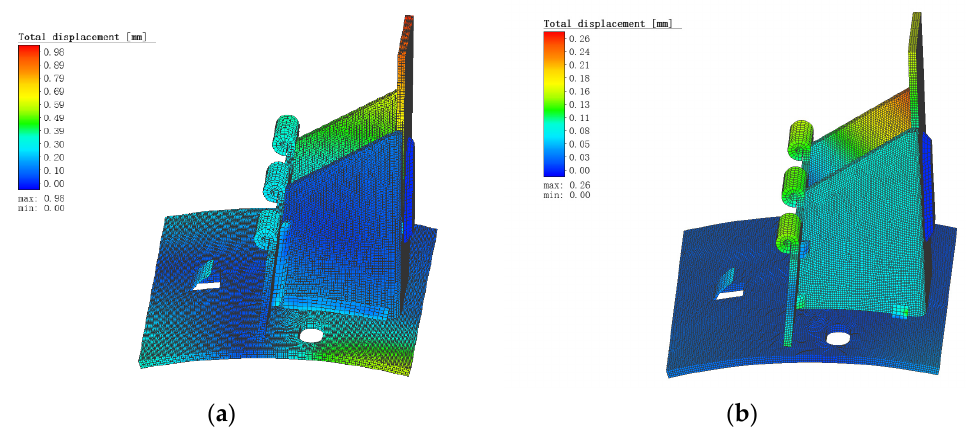
Figure 7. Total displacement diagram under continuous welding and spot welding conditions. ( a ) Continuous welding; ( b ) spot welding.